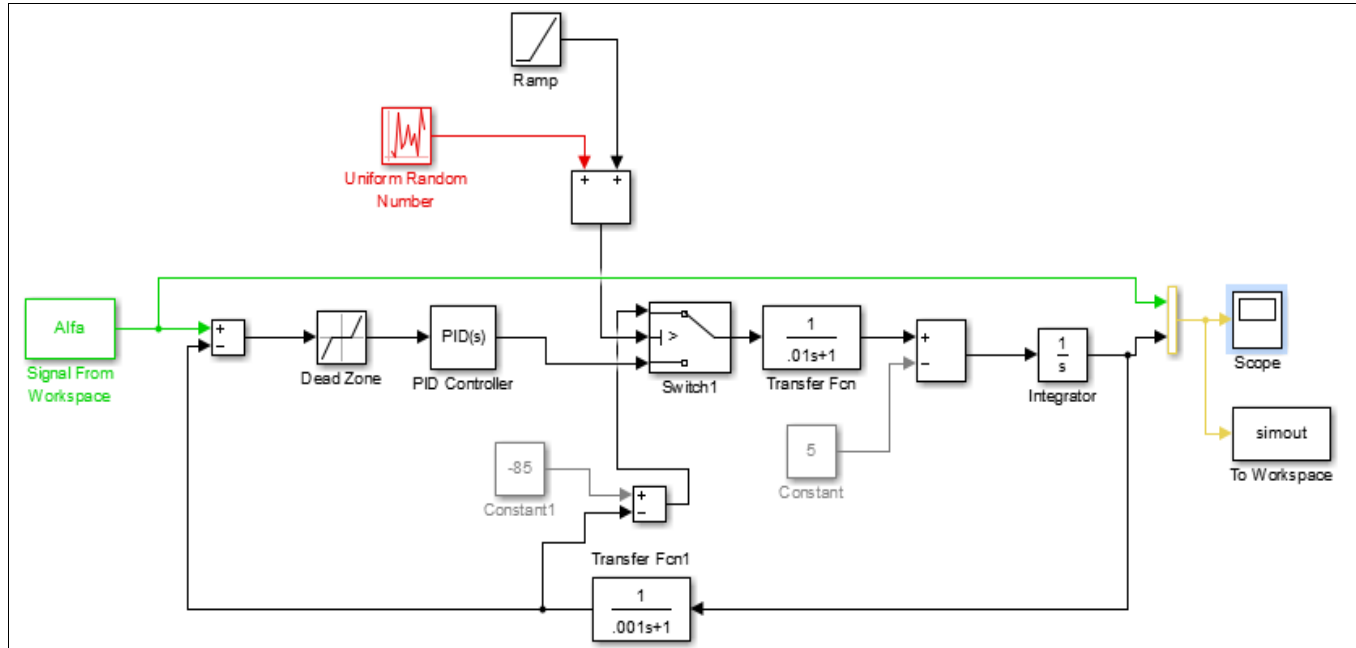
Figure 21: Diagram of the solar tracking control system implemented in Simulink.